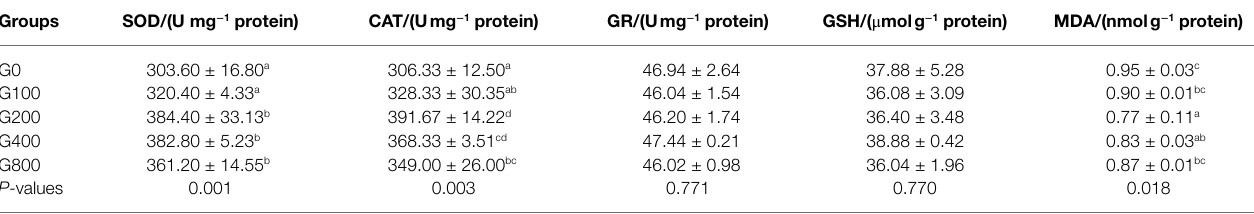
TABLE 5 | Effects of dietary GSH on the antioxidant capacity of mid-intestine in O. mykiss (mean ± SD, n = 9). Groups